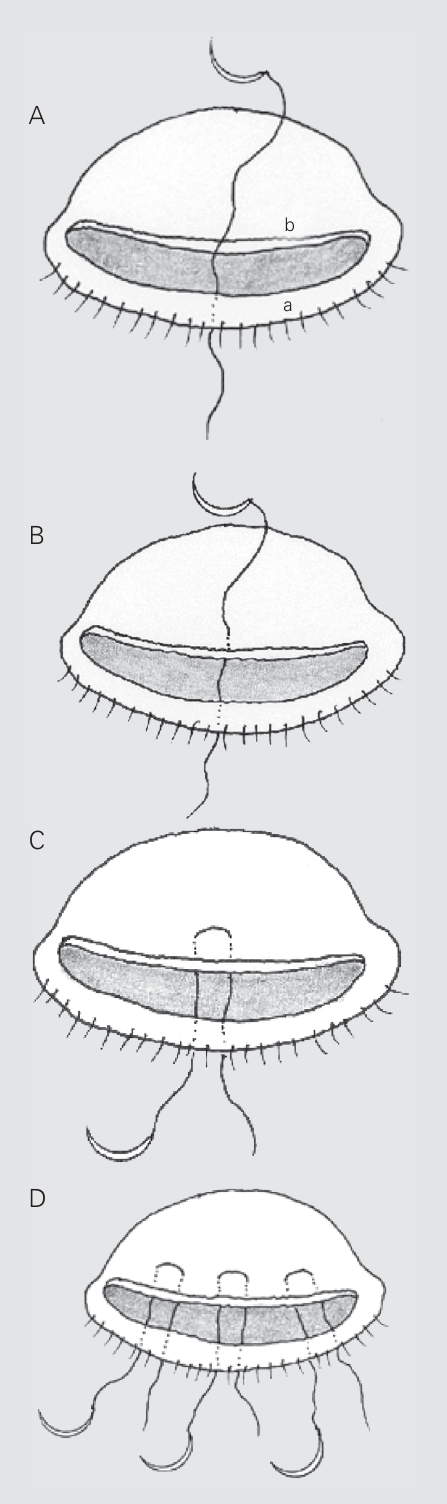
Figure 1. A , Surgeon’s view: a curvilinear incision has divided the tarsal plate into two por- tions: marginal (a) and distal (b). A single-armed suture was in- serted at the center of the lid through the anterior lamella, just behind the lash line, passed un- der the marginal tarsal portion and emerged in the defect cre- ated by the incision. B , The needle was next passed through the distal tarsal portion and passed back under the mar- ginal portion emerging at the anterior lamella. C , Additional sutures are passed in the same manner laterally and medially. D , Final result: the distal tarsal por- tion (dotted line) is now over the marginal